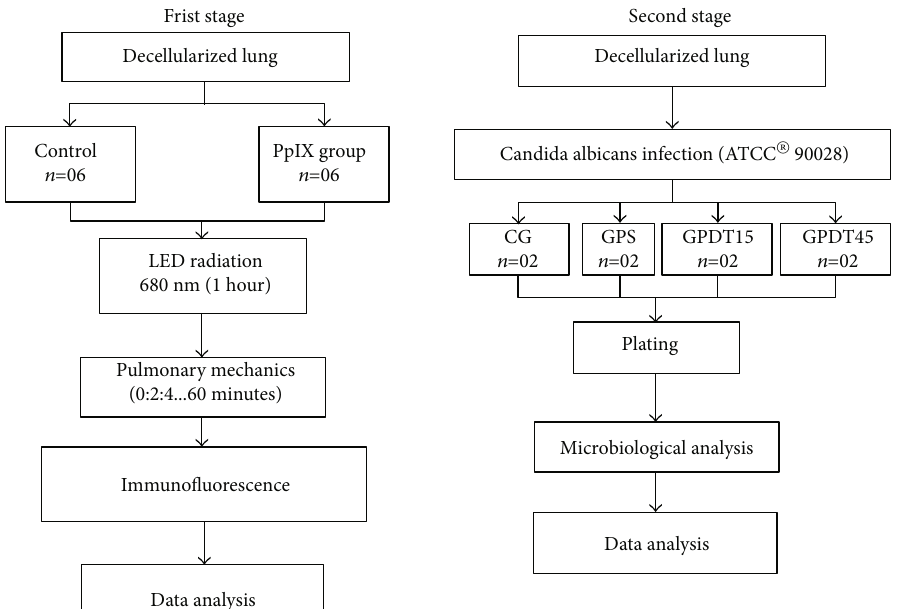
Figure 1: Flowchart of the study.